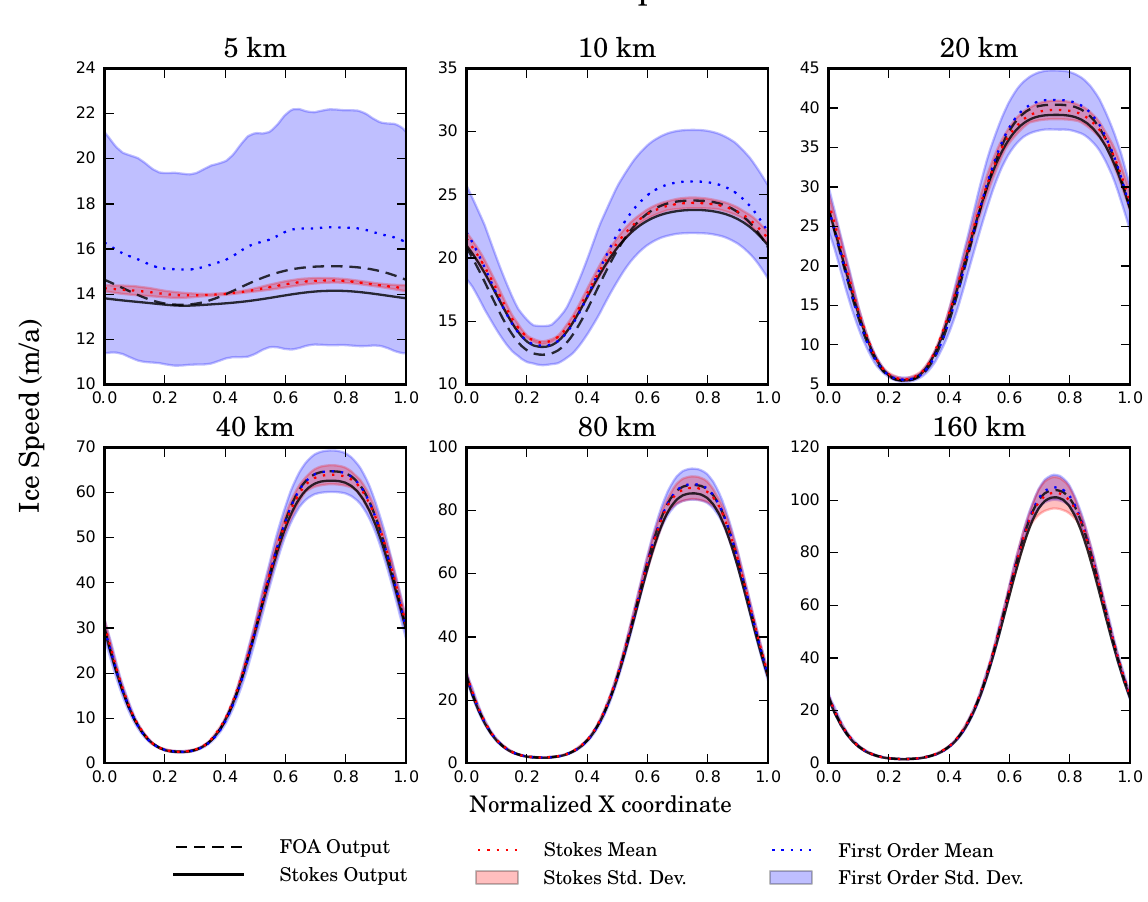
Fig. 4. ISMIP-HOM A performed using first-order and Stokes’ approximations.